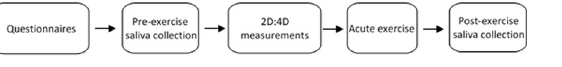
Figure 1. The study